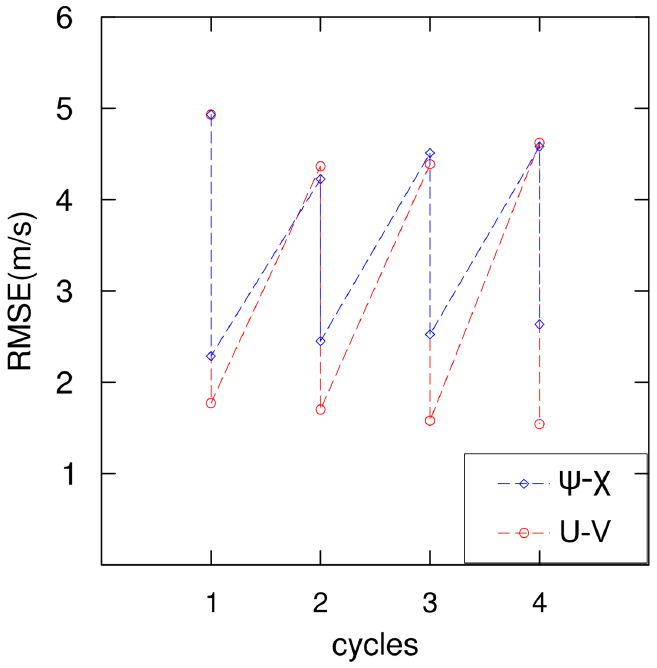
Figure 7. The forecast and analysis (sawtooth pattern during DA cycling) of RMSE of radial velocity (m s − 1 ) for ψ−χ and U − V control variable from 2100 UTC 04 June to 0000 UTC 5 June 2019 for the 4 data assimilation cycles indicated in x axis.